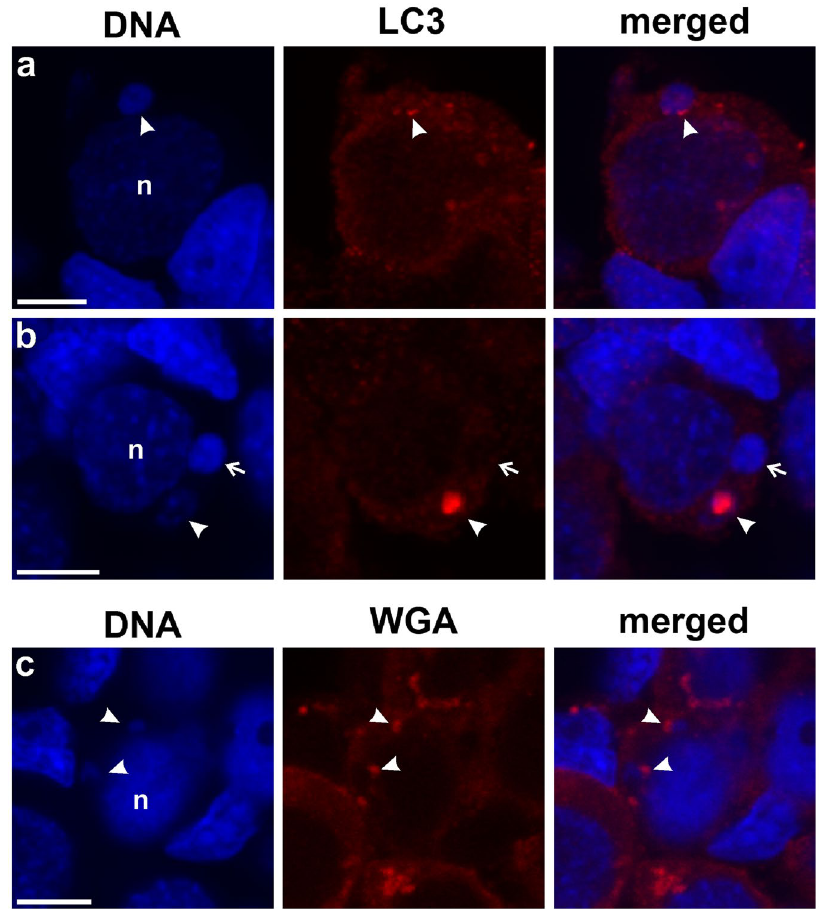
Figure 7. Autophagosome markers are accumulated in the micronuclei. Immunofluorescence staining of paraffin sections from gonads of diploid female at 35 Gosner stage: LC3 autophagosome marker (red), DNA counterstained with DAPI (blue) ( a , b ). ( a ) Dotted and linear aggregates of LC3 (arrowhead) on the surface of highly condensed micronuclear chromatin may represent the early stage of autophagosome formation. ( b ) Large LC3 aggregate (arrowhead) on the micronucleus and between the chromatin clumps. Note that DNA is less condensed and fragmented with an empty interior which may represent the later stage of autophagic process connected with DNA degradation. Second micronucleus (arrow) is highly heterochromatinized and apparently not autophagic. ( c ) Immunofluorescence of frozen tissue sections of an ovary from diploid female at 29 Gosner stage showing wheat germ agglutinin (WGA, red) staining of cellular membranes, DNA counterstained with DAPI (blue). Note the cap-shaped WGA aggregates (arrowheads) at the surface of micronuclei which we interpret as staining of fusion site of autophagosome membranes. The irregular shape of the left micronucleus could reflect chromatin degradation. Additional strong intra-cytoplasmic agglomerates or dots, visible in upper and lower cells, could be trans -Golgi cisternae and post-Golgi membranes, e.g. lysosomal membranes. Confocal images represent projection of 9 z-sections ( a ) or single z-section ( b , c ) (0.46 µ m). N – nucleus. Scale bars 5 µ